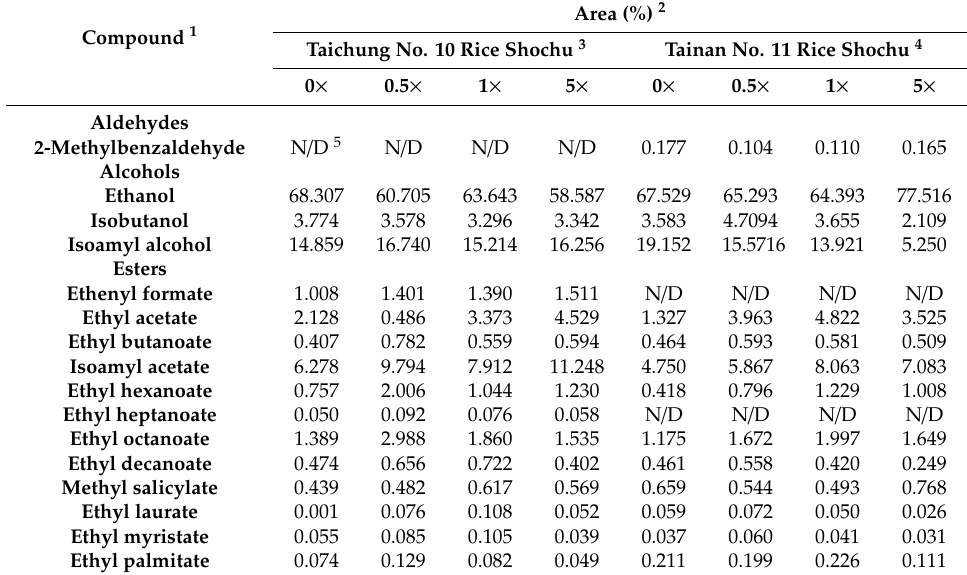
Table 3. Analysis of volatile compound composition in Taichung No. 10 rice shochu and Tainan No. 11 rice shochu after DOWC